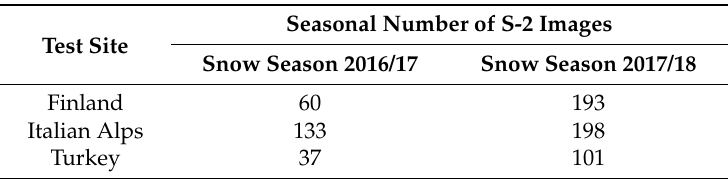
Table 4. Seasonal effective number of S-2 images at each test